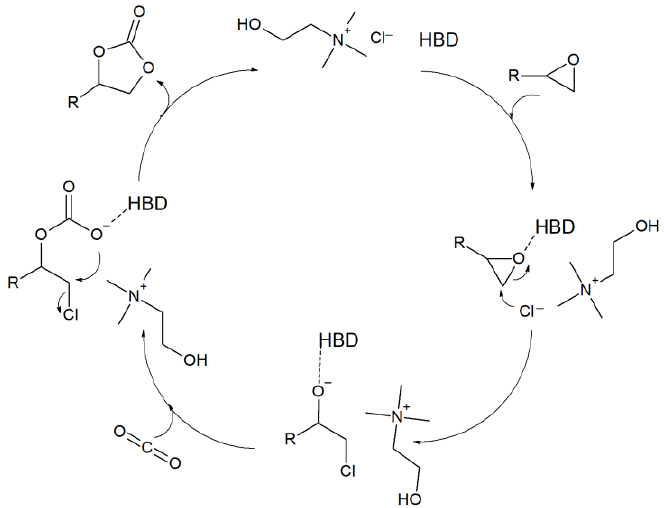
Figure 2. Proposed mechanism for cyclic carbonate synthesis catalyzed by a ChCl-based deep eutectic solvent [36].